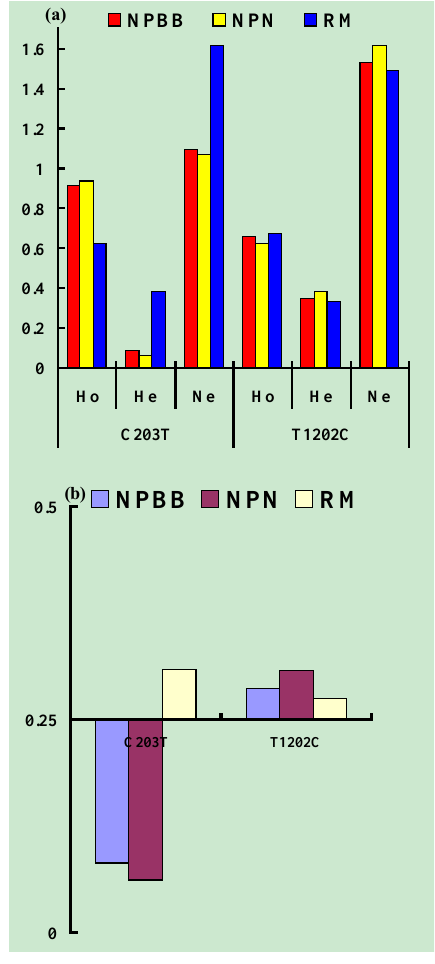
Figure 3. Genetic diversity parameters at the SNPs c.203C > T and c.1202T > C from the TYRP1 gene in Nanping black- boned (NPBB), Nanping normal (NPN) and Romney Marsh (RM) sheep. (a) Ho: gene homozygosity; He: gene heterozygosity; Ne: ef- fective allele numbers. (b) PIC: polymorphism information